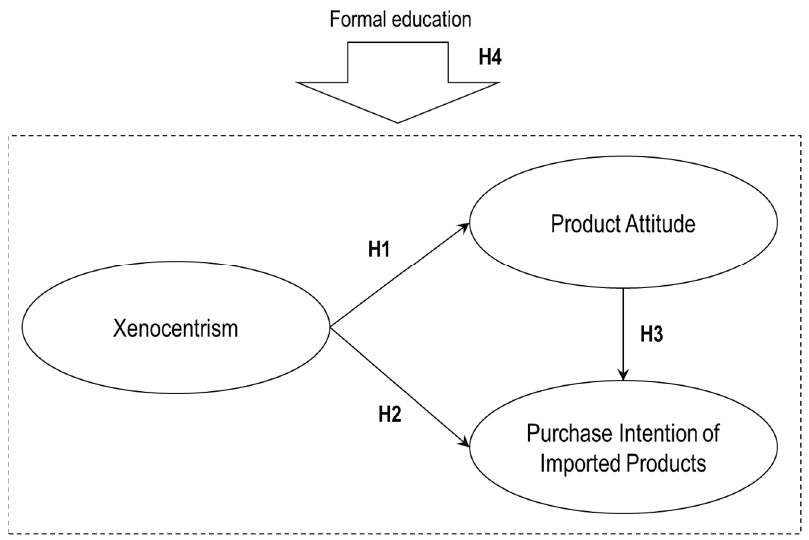
Figure 1. Research